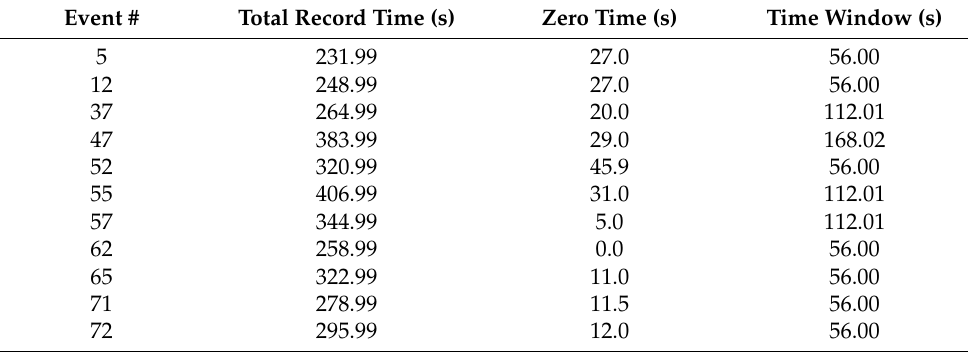
Table 4. Time window duration for each analyzed event.